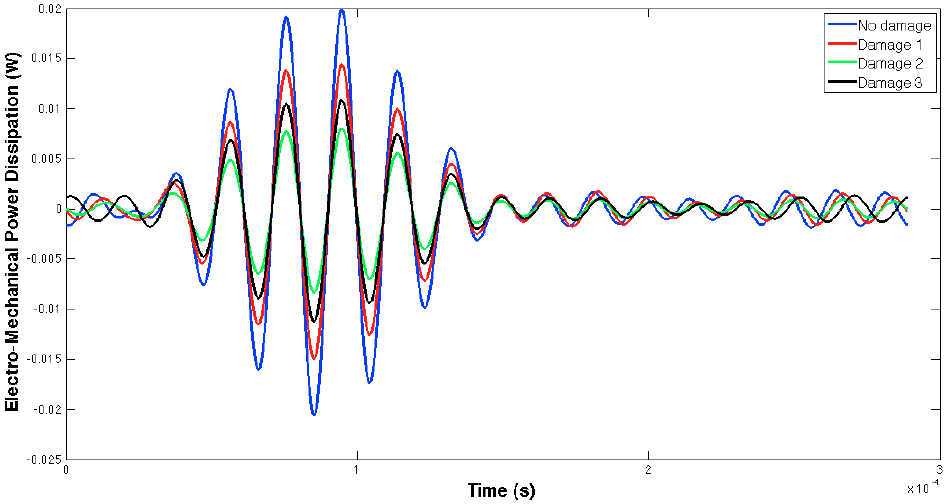
Figure 5. EMPD at 50 kHz. Tone-burst sent from sensor 1 to sensor 2.